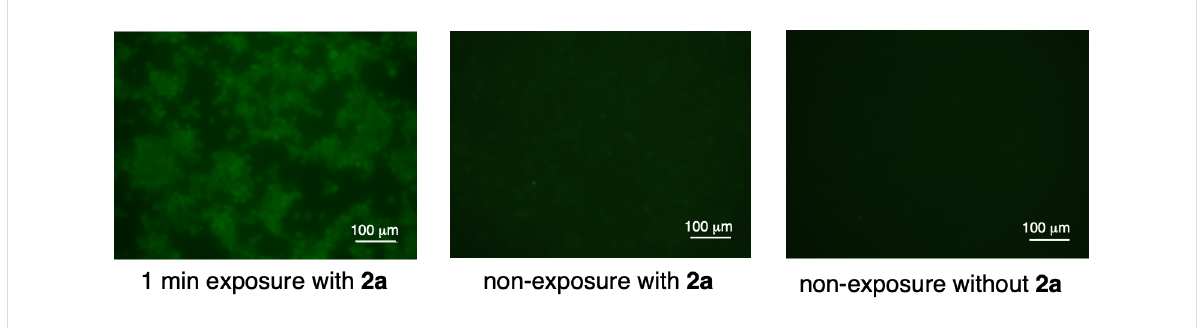
Figure 6: Detection of intracellular ROS only in irradiated LLC cells with 2a -containing medium.